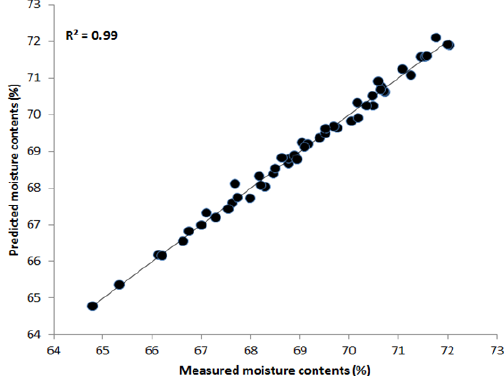
Figure 7. Regression plot of raw and predicted moisture data (700–1,000